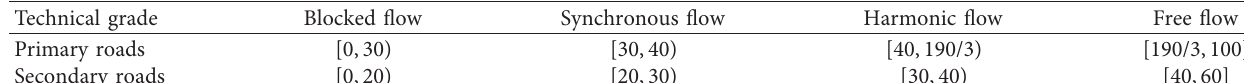
Figure 8: Two architectures of NARX networks. (a) Parallel architecture. (b) Series-parallel architecture. Table 2: State classification intervals of the regional road network.